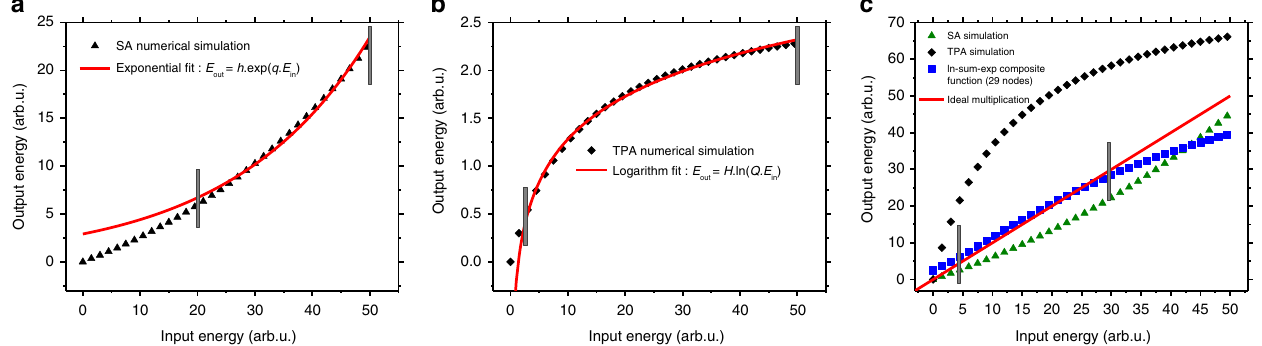
Fig. 3 Numerical simulation of multiplication. a Comparison of the saturable absorption (SA) solution with an exponential function E out = h .exp( q . E in ). Fit coef fi cients are h = 2.906 and q = 0.041 and parameter values of the numerical simulation are α 0 = 5(arb.u.), E sat = 70(arb.u.) and L = 0.3(arb.u.). b Comparison of two photon absorption (TPA) solution with a natural logarithm function E out = H .ln( Q . E in ). Fit coef fi cients are H = 0.646 and Q = 0.723 and parameter values of the numerical simulation are α 0 = 5(arb.u), L = 0.3(arb.u.) and β = 0.5(arb.u.). c The blue squares show the composite mathematical operations of ln-sum-exp for 29 inputs and the solid red line represents ideal multiplication. The normalized-root-mean-square (NRMSE) of less than 1% (between simulated multiplication and the ideal multiplication) occurs between the bounded range, which is input energies between about 19 (arb.u.) to 32 (arb.u.)